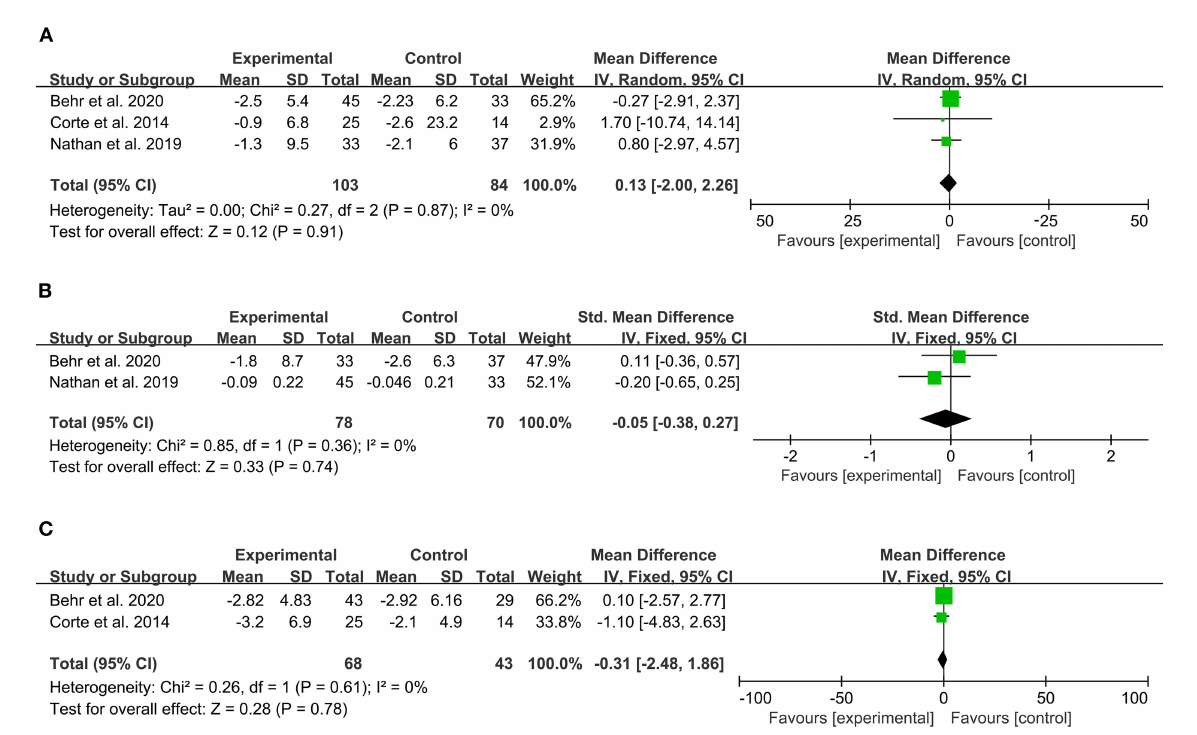
FIGURE4 Forest plot illustrating a comparison of effects of PAH-specific therapy on lung function in PH-ILD. (A) Change of FVC, % predicted. (B) FEV1, % predicted (C) DLCO, % predicted.